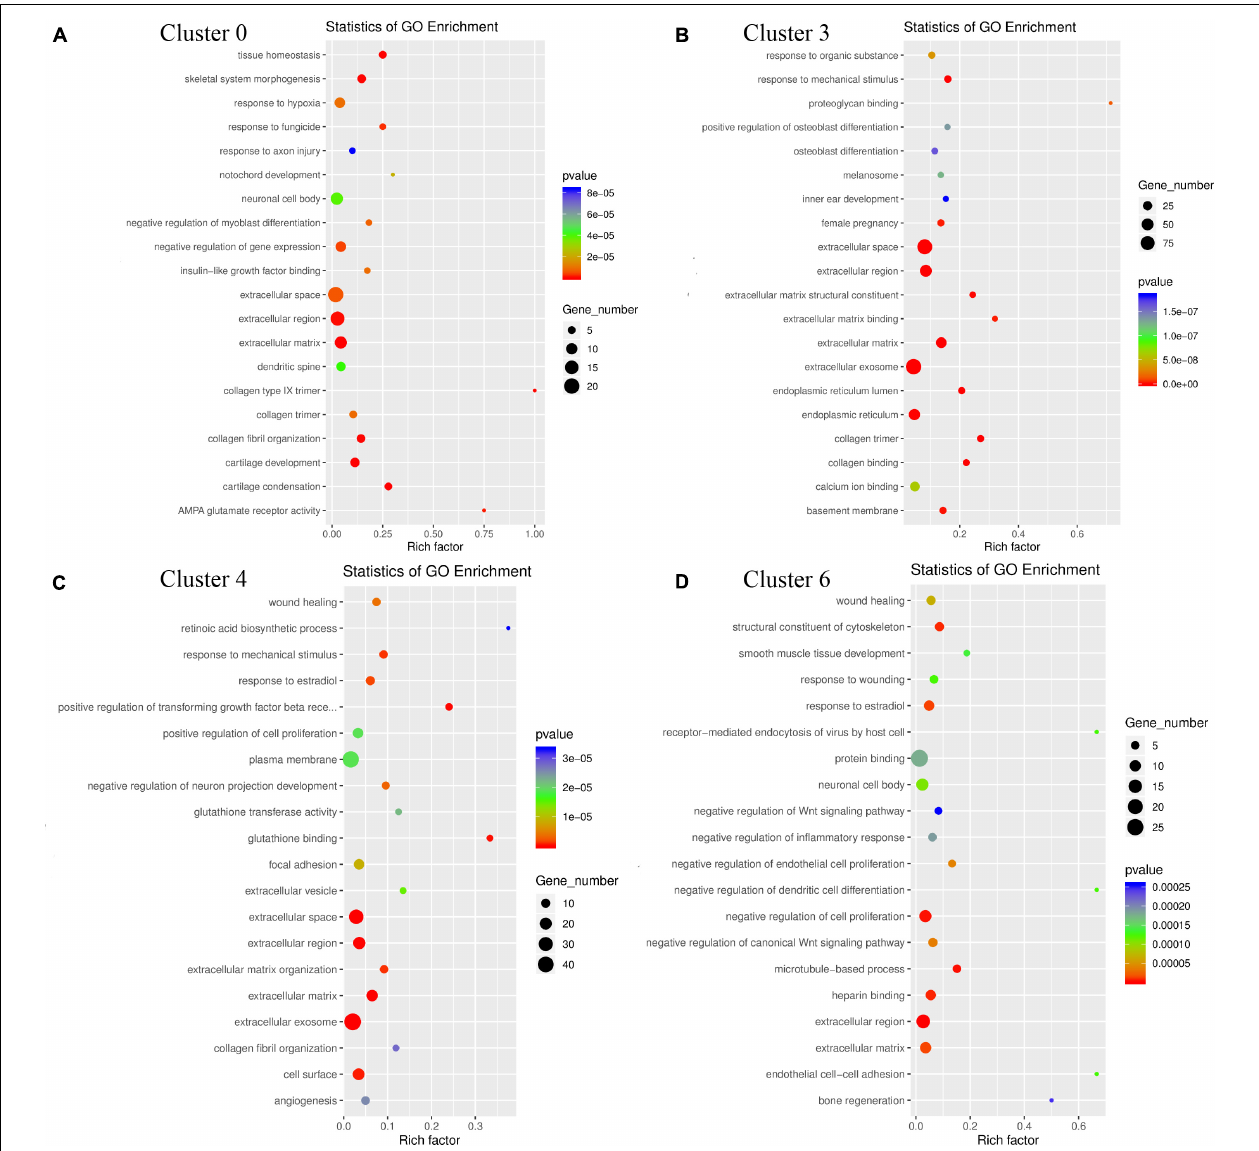
FIGURE 10 | GO enrichment analysis of genes for the heterogeneity of cluster 0 (A) , cluster 3 (B) , cluster 4 (C) , cluster 6 (D) . The triangle size indicates the significance and corresponding significance values displayed as log10 ( P